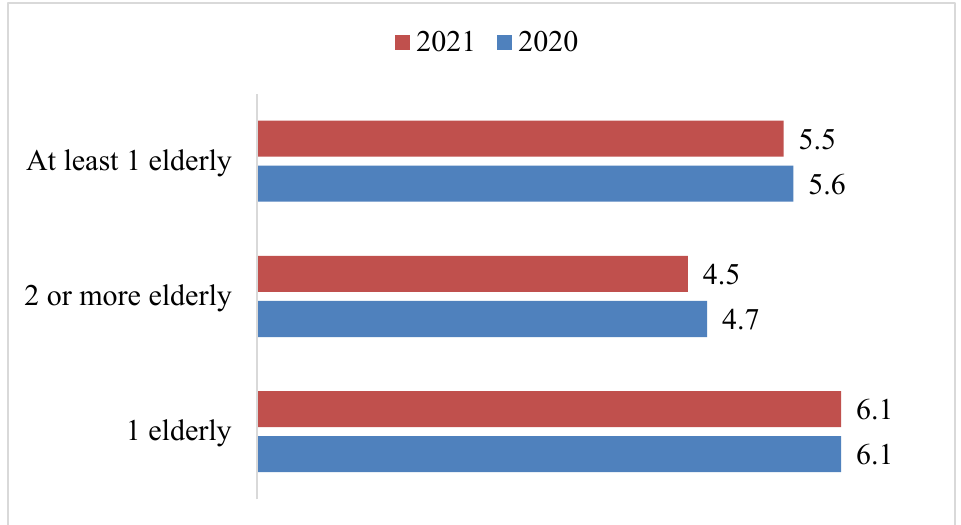
Figure 6. Poverty rate trends in households, by number of elderly people, 2020–2021. Source: own